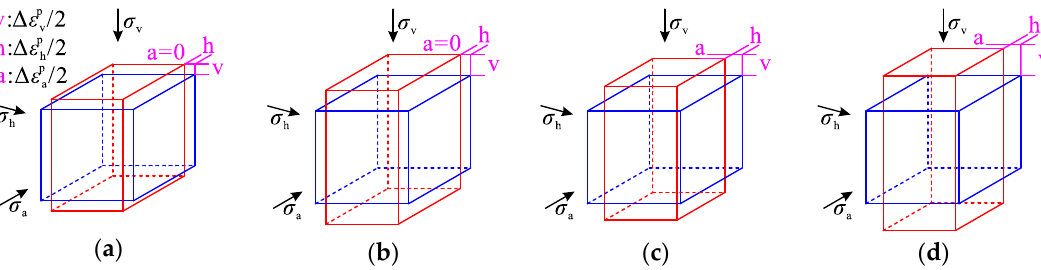
Figure 4. Plastic principal strain increments of the microunit at the middle of the tunnel roof: ( a ) perfectly elastoplastic model, ( b ) considering only dilatancy, ( c ) considering only strain softening, and ( d ) considering both strain softening and dilatancy.